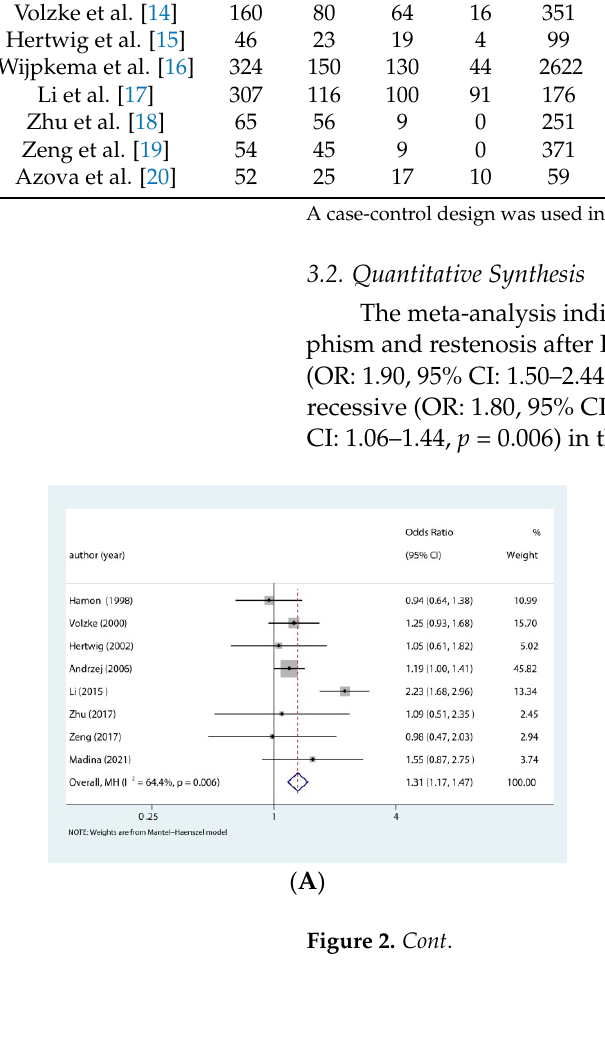
Table 3. ANT1R rs5186 polymorphism genotype distribution and allele frequency in cases and con-